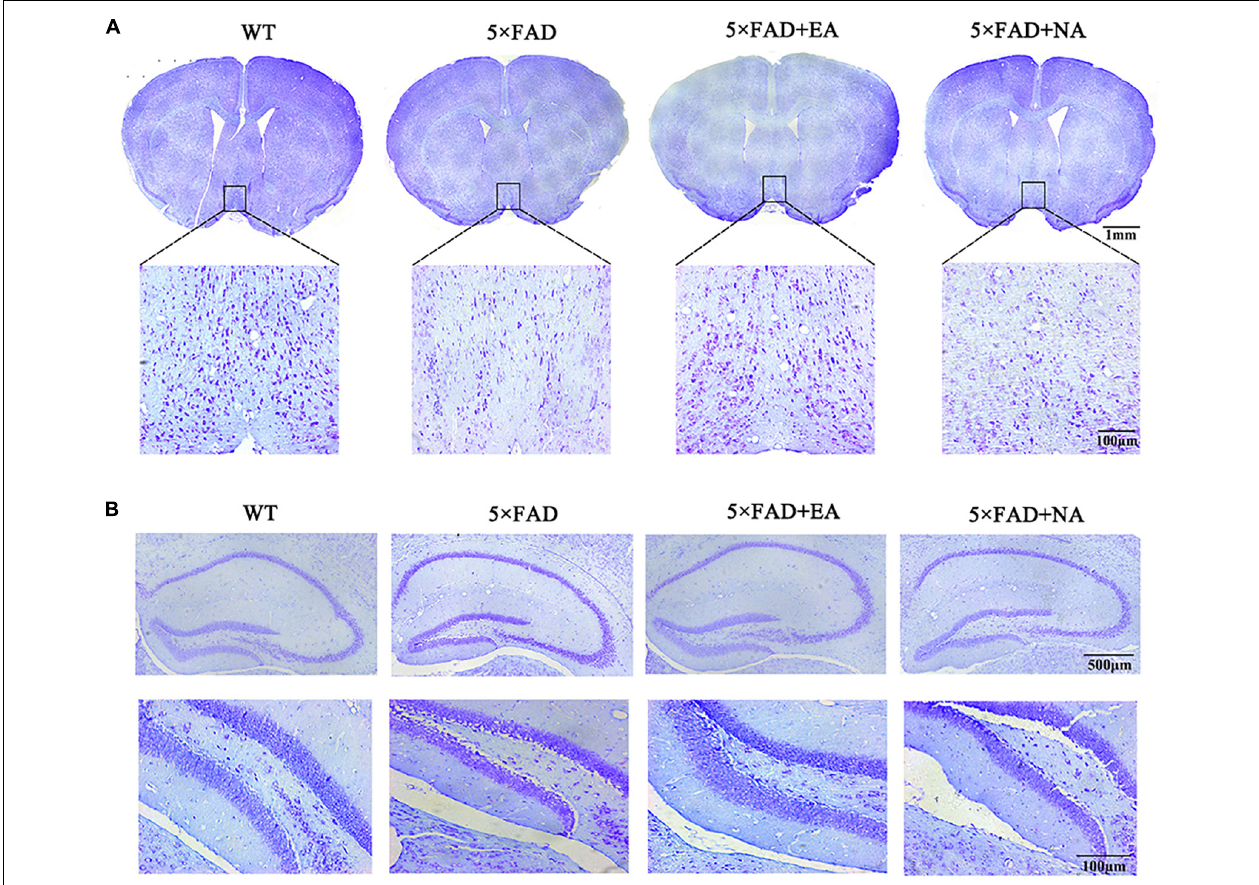
FIGURE 5 | Nissl staining results of WT, 5 × FAD, 5 × FAD + EA, and 5 × FAD + NA group after treatment. (A) Nissl staining pictures of basal forebrain level (Top, scale bar = 1 mm) and the black frame area indicates the field of view of the MS/VDB. 200 × photomicrographs of MS/VDB (Bottom, scale bar = 100 mm). (B) Nissl staining pictures in the hippocampus (Top, scale bar = 50 µ m) and 200 × photomicrographs of DG (Bottom, scale bar = 100 µ